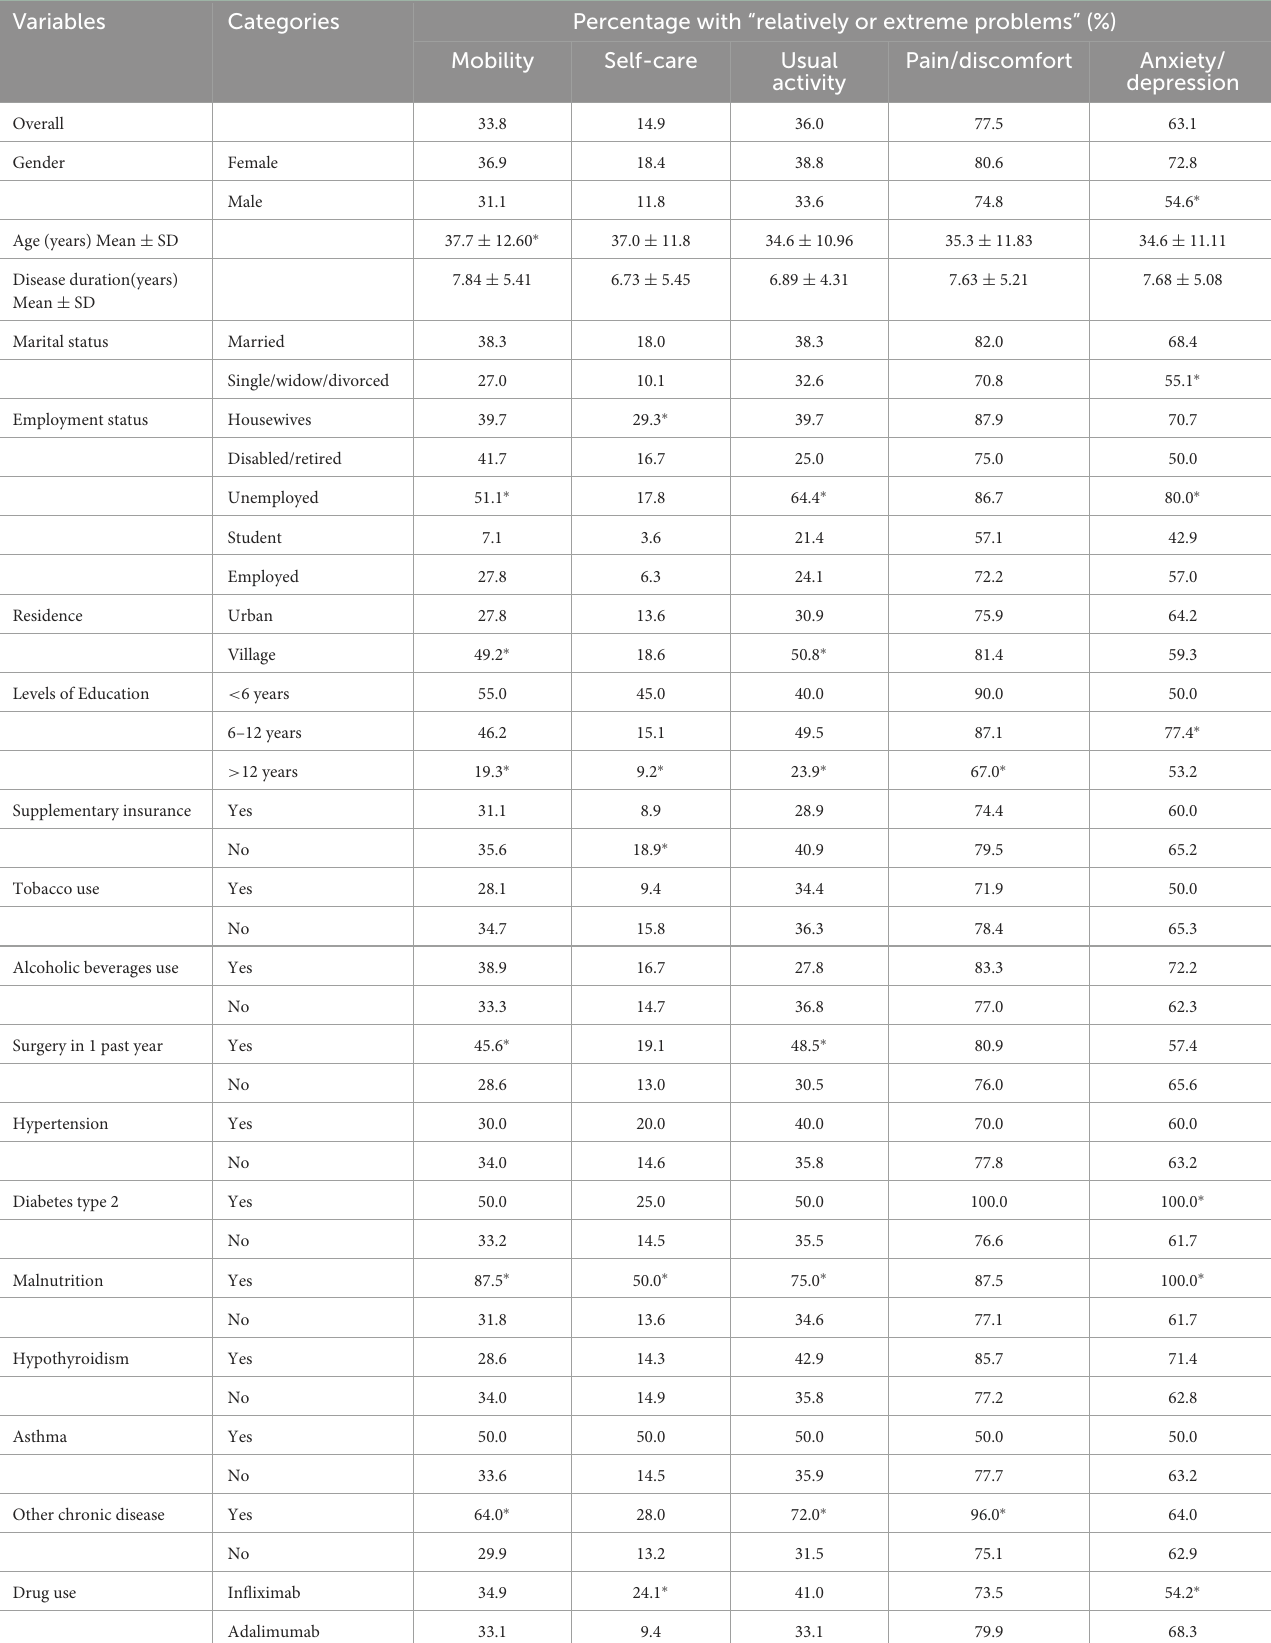
TABLE 2 Percentages of patients with “relatively or extreme problems” in each of the five dimensions of EQ-5D stratified by socio-demographic and clinical characteristics. Variables Categories Percentage with “relatively or extreme problems” (%) Mobility Self-care Usual Pain/discomfort Anxiety/ activity